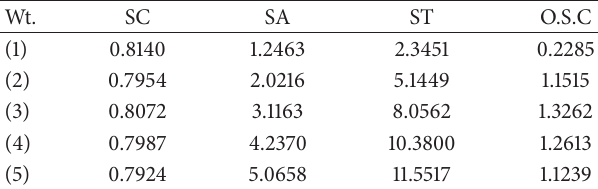
Table 3: Data of the variation of fibre weight